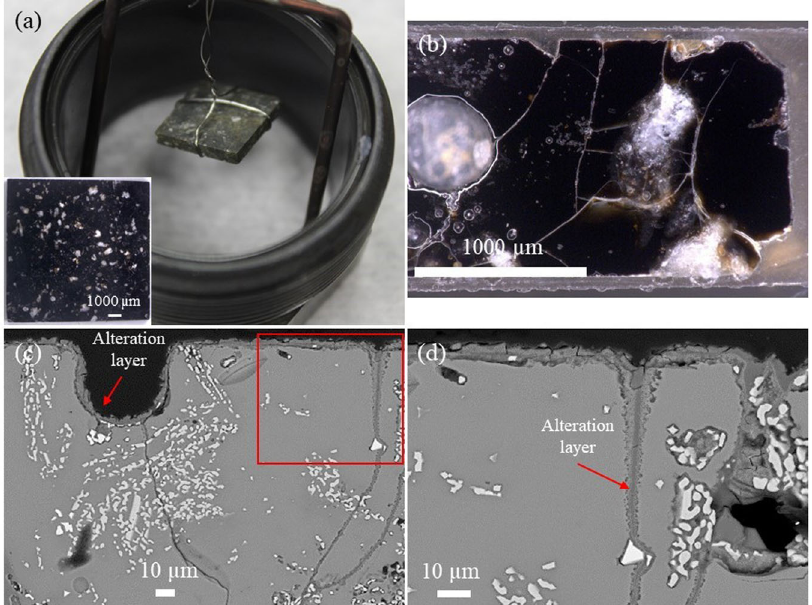
Fig. 5 BA5 1250 °C glass coupon after the 49-day VHT. a The post-reaction coupon suspended from the stainless-steel apparatus at the end of the reaction (inset shows pre-reaction coupon), ( b ) optical micrograph of a polished cross section, ( c ) and ( d ) BSE-SEM cross sections at different magni fi cations (the red box is the area associated with ( d